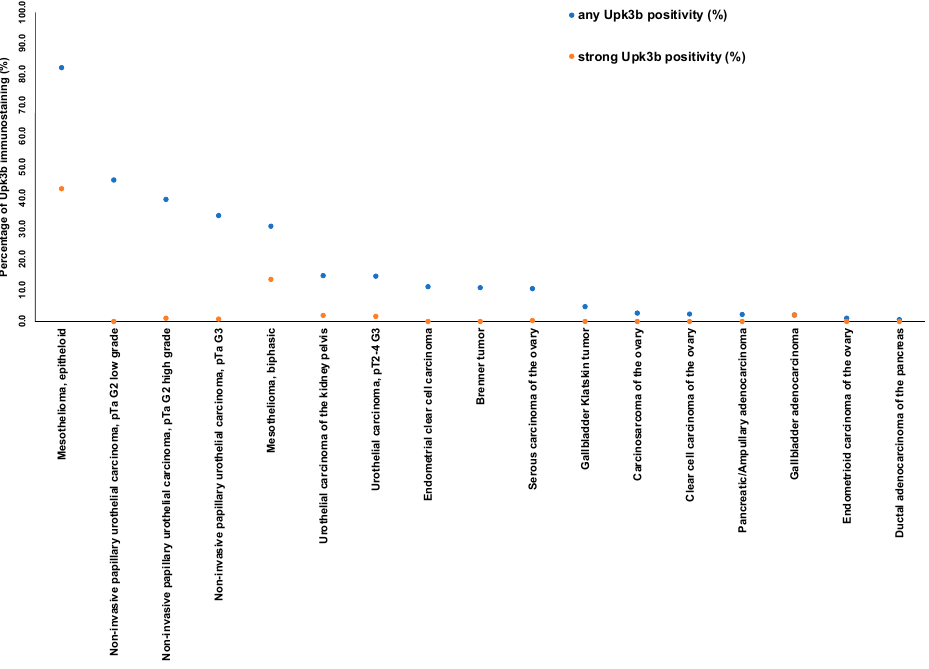
Figure 4. Ranking of cancers according to the fraction of Upk3b positive cases. Both the percentage of positive cases (blue dots) and the percentage of strongly positive cases (orange dots) are shown. Within non-invasive urothelial neoplasms of the urinary bladder, the rate of Upk3b positive cases decreased from 61.9% in pTaG2 (low grade) to 58.0% in pTaG3 (high grade, p < 0.05, Table 2). Table 2. Upk3b immunostaining and tumor phenotype.